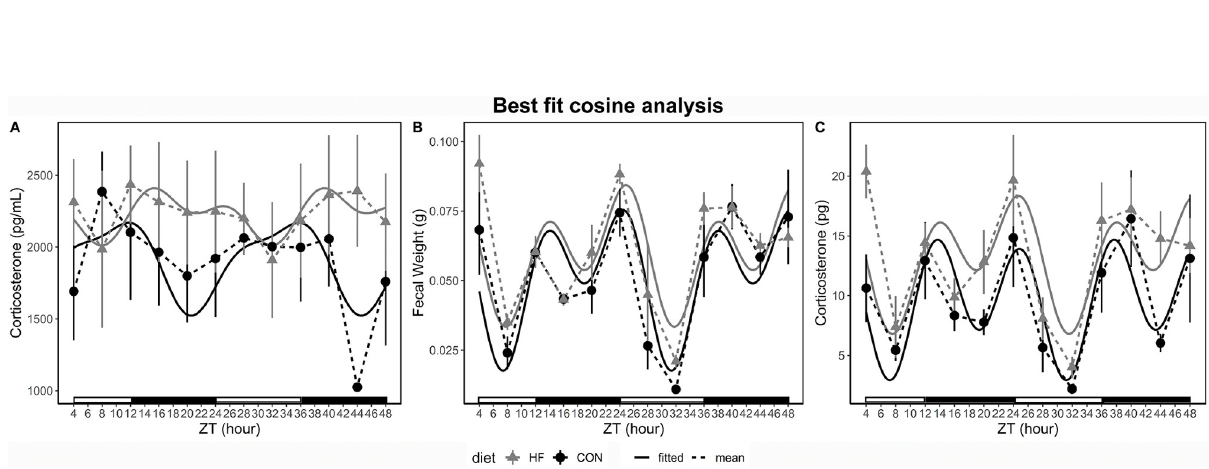
Fig 4. Best fit cosine curve analysis for fecal corticosterone concentration, fecal weight, and total corticosterone produced. A) Two-component cosine analysis of corticosterone concentration (pg/mL) over 48 hr. CON (n = 4 cages) R 2 = 0.47 and HF (n = 5 cages) R 2 = 0.61. B) Two-component cosine analysis of fecal weight (g) over 48 hr. CON (n = 4 cages) R 2 = 0.69 and HF (n = 5 cages) R 2 = 0.50. C) Two-component cosine analysis of total corticosterone in feces (pg) over 48 hr. CON (n = 4 cages) R 2 = 0.73 and HF (n = 5 cages) R 2 = 0.48. Black dash line represents mean of CON cages, and solid black line represents fitted cosine curve of CON cages. Gray dash line represents mean of HF cages, gray black line represents fitted curve of HF cages. Data points within dashed lines are mean ± standard deviation. White and black bars above the x-axis represent the light and dark phases of the light-dark cycle. ZT, refers to zeitgeber time, with ZT0 presenting the time of light onset on the day sampling was begun.